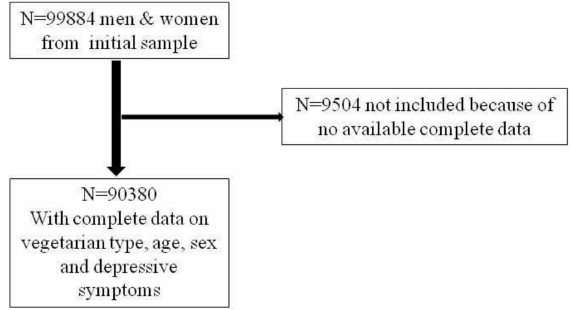
Figure 1. Flowchart of included sample. n :